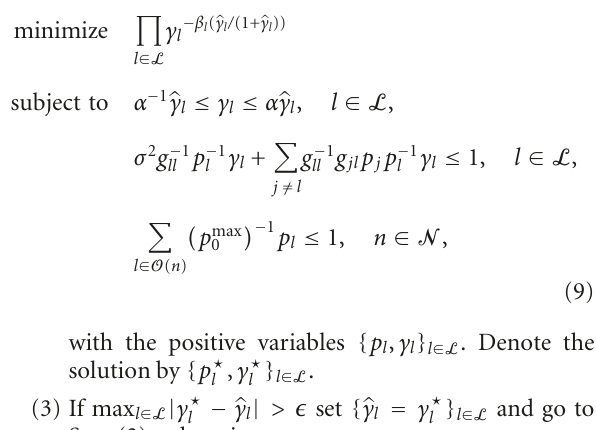
Algorithm 3 (Successive approximation algorithm for RA